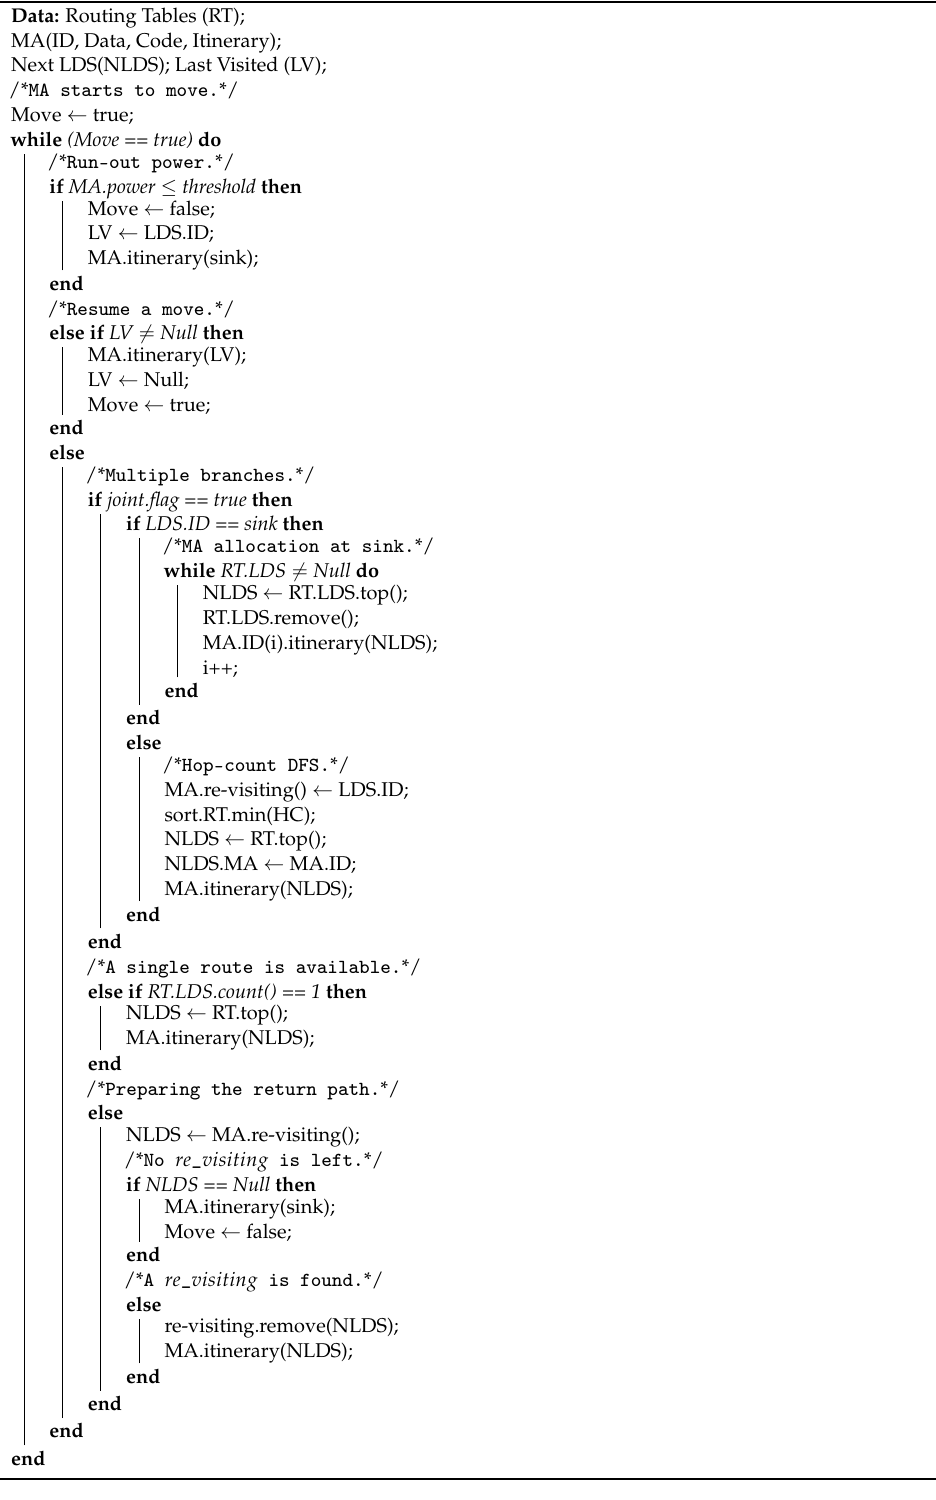
Algorithm 4: UAV migration